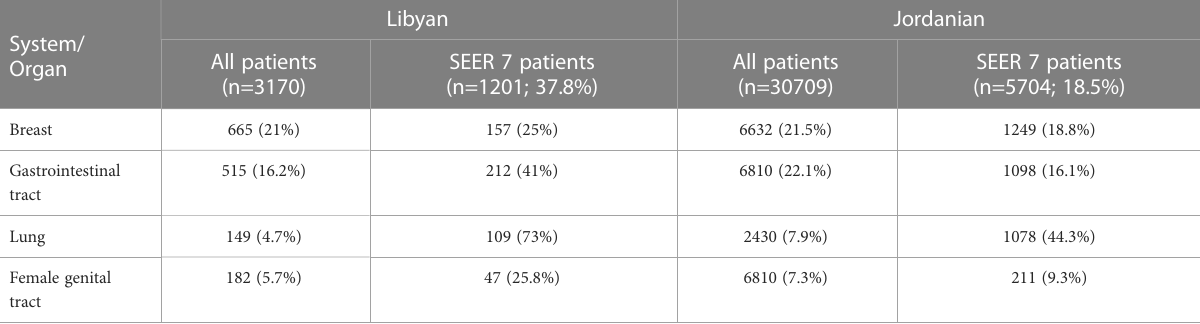
TABLE 5 Comparison of between Jordanian and Libyan patients with cancer in terms of cases presenting with SEER stage 7 advanced cancer.